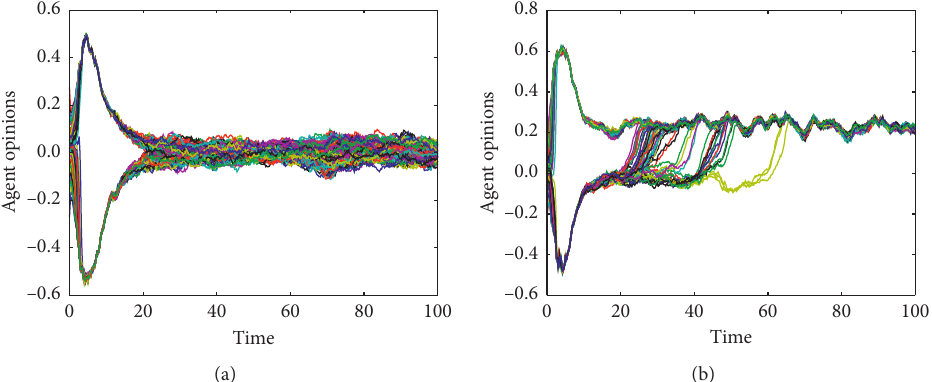
Figure 5: Opinion trajectories for the case of consensus . (a) α bias toward positive opinions